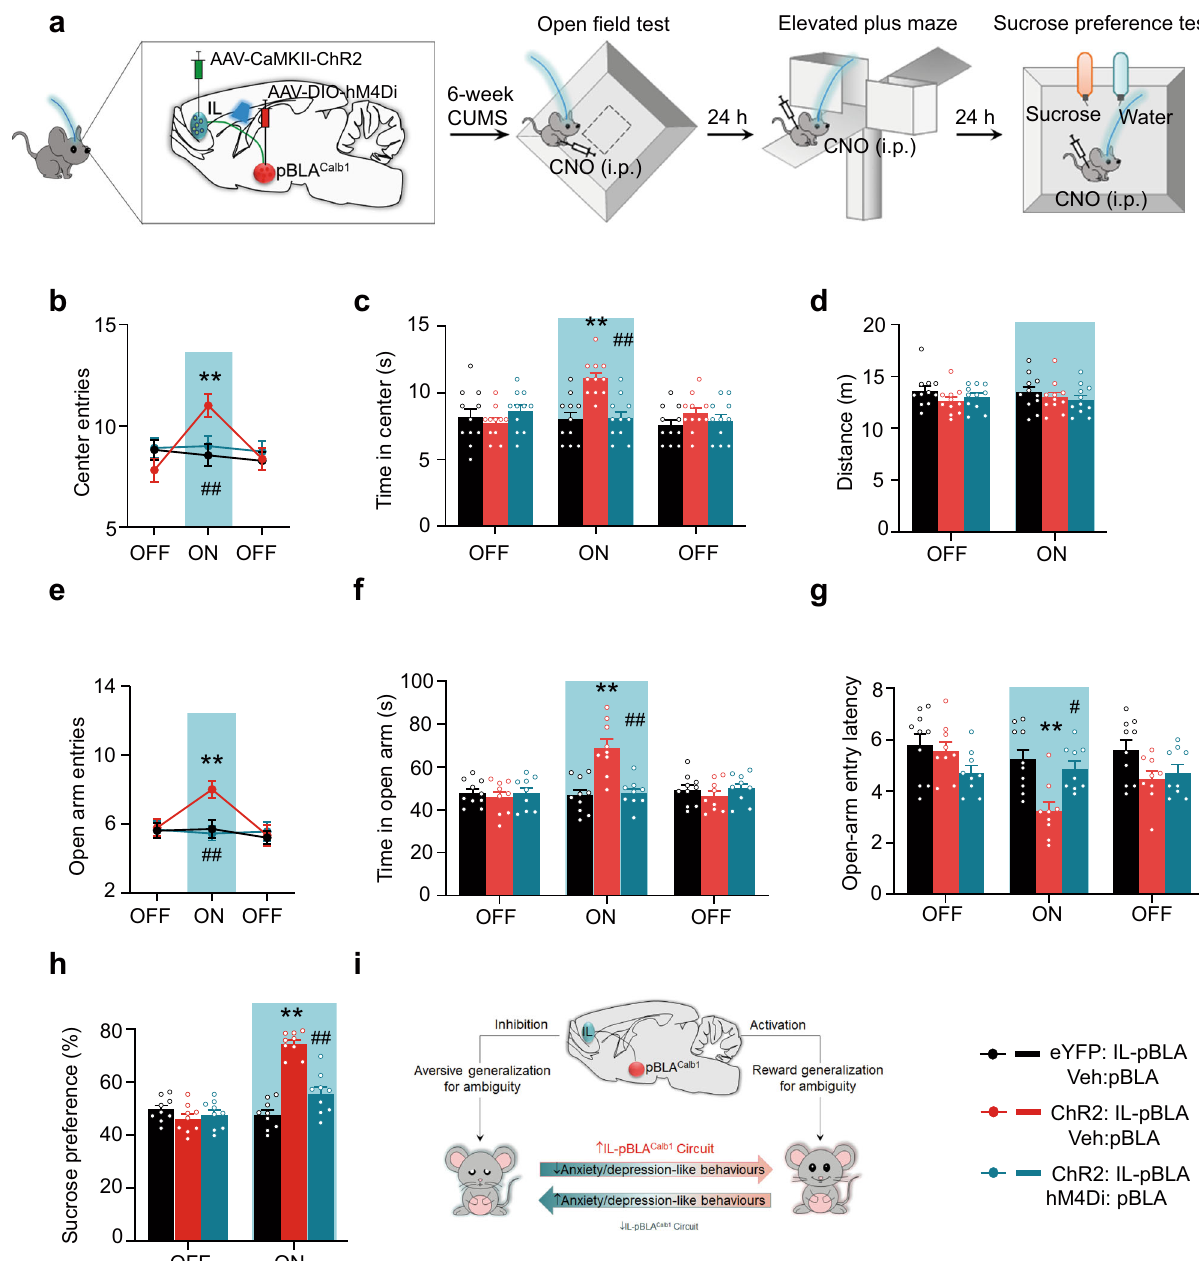
Fig. 5 | Activating IL – pBLA Calb1 circuit ameliorates anxiety- and